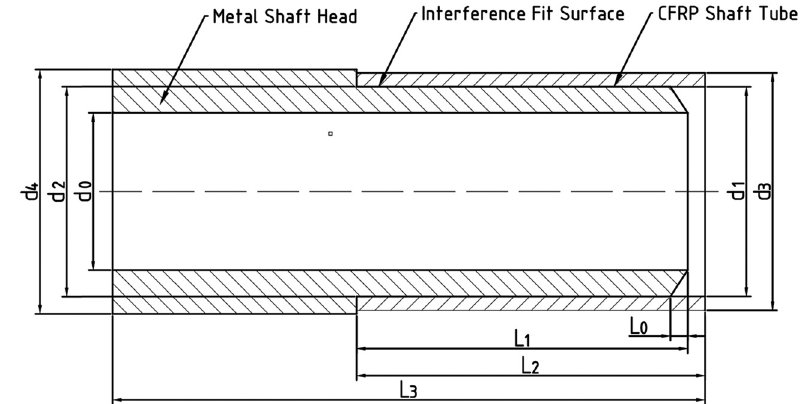
Figure 4: Schematic diagram of the interference fi t joints.